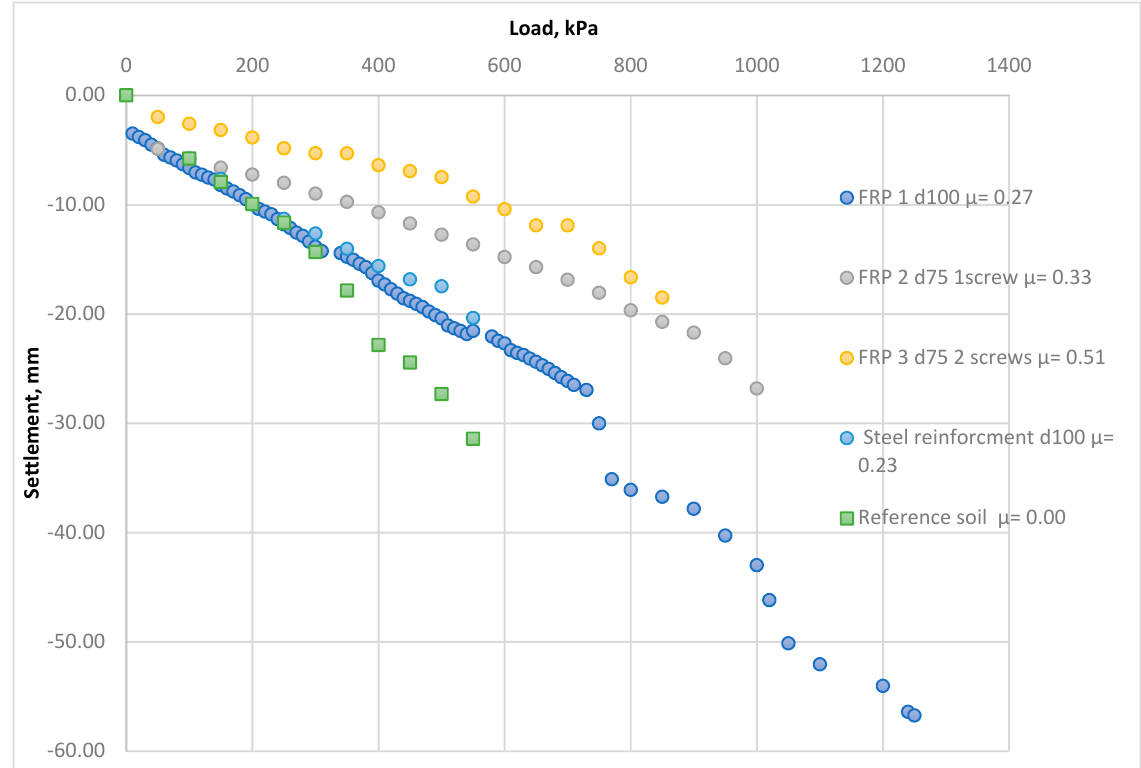
Figure 6. Load − settlement graphs of the tested samples before and after the reinforcement according to the field plate load tests (PLT) results.